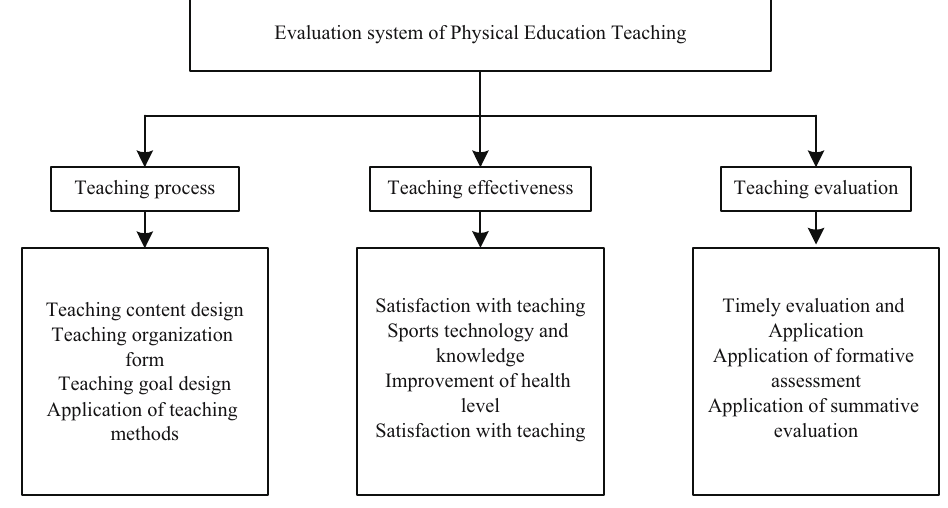
Figure 2: Process of physical education teaching evaluation